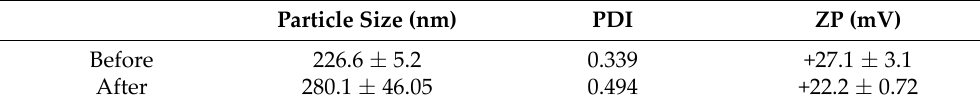
Table 3. Chitosan nanoparticles’ physical characteristics before and after